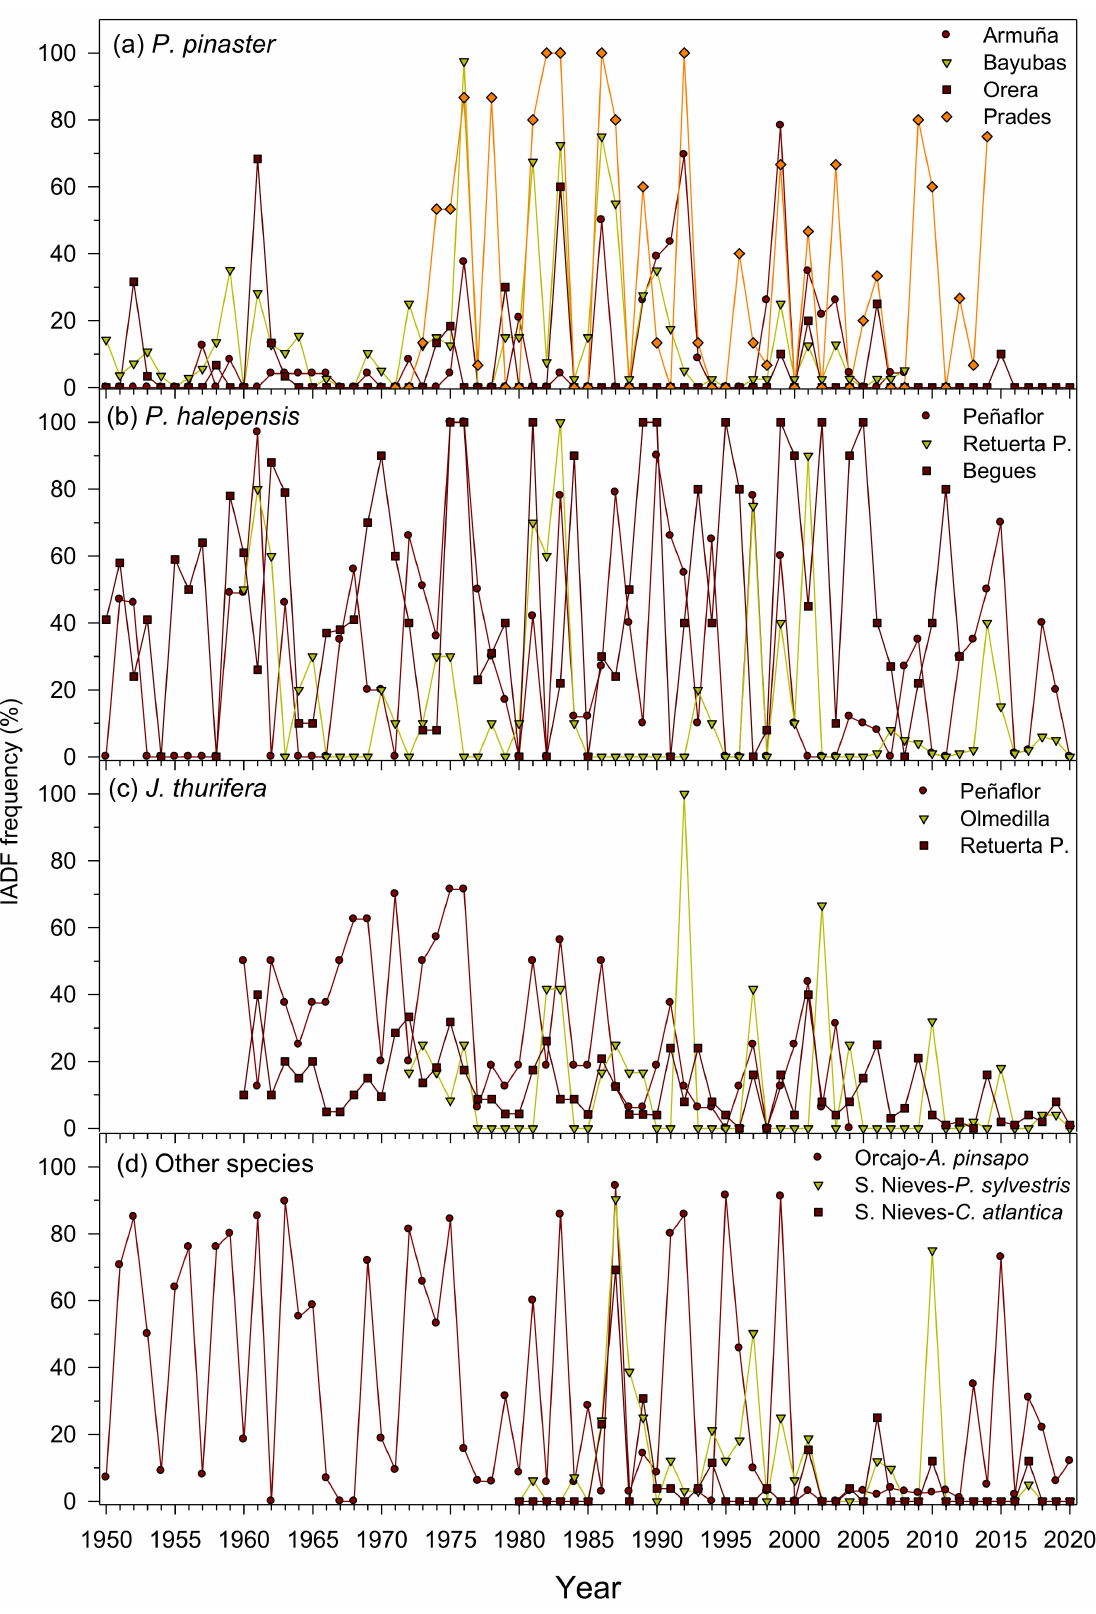
Figure 2. Mean annual frequency of latewood IADFs observed in the six study species: ( a ), P. pinaster ; ( b ), P. halepensis ; ( c ), J. thurifera ; and ( d ), other species. Data correspond to the period